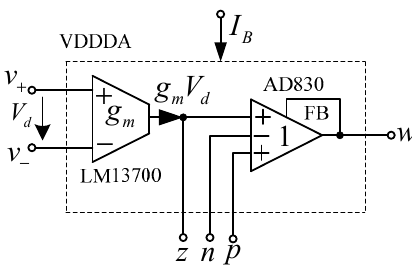
Figure 19. VDDDA based on the commercial components.